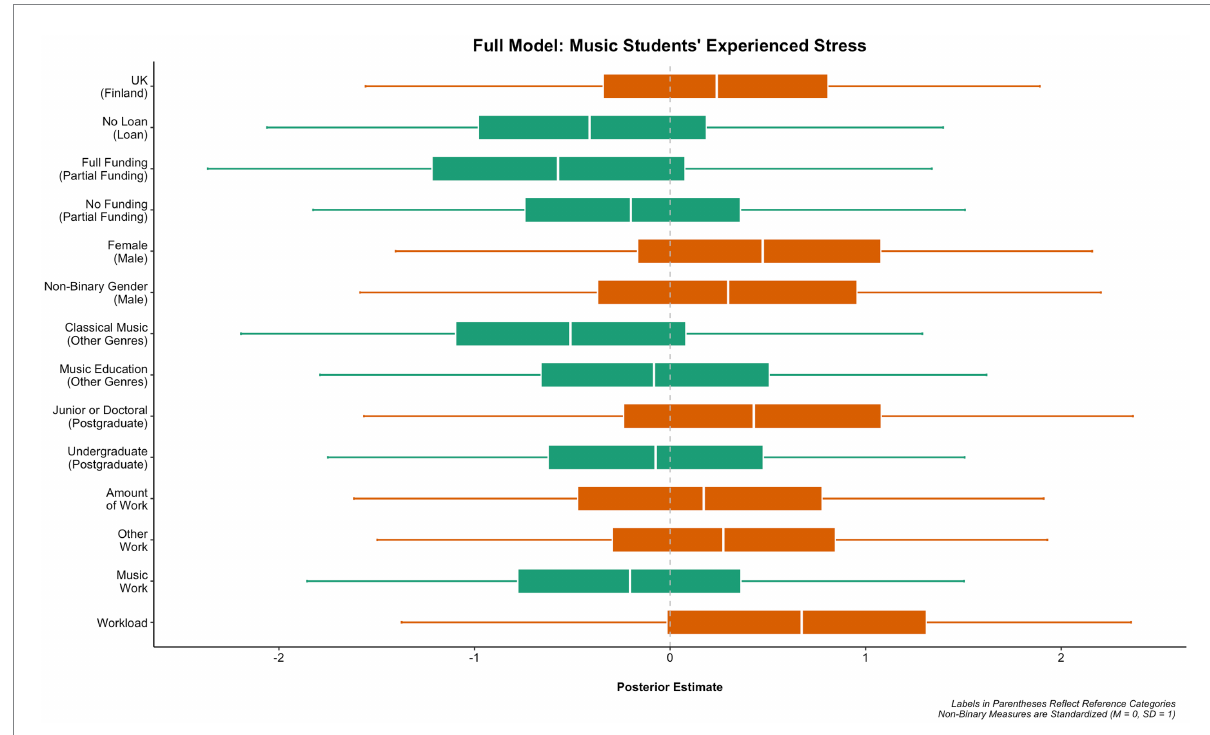
FIGURE 7 Population-level predictors of experienced stress, derived from a Bayesian mixed-effect probit regression. The boxes denote 50% posterior intervals and the lines denote 95% posterior intervals. With binary items, the left-hand side boxes indicate a smaller effect on stress than in the reference group in brackets, and the right-hand side boxes indicate a greater effect on stress than in the reference group in brackets. With the working and workload items (the four bottom items on the figure), the left-hand side boxes indicate a negligible effect on stress and the right- hand side boxes indicate the greater effect on stress the nearer the box is to the right-hand